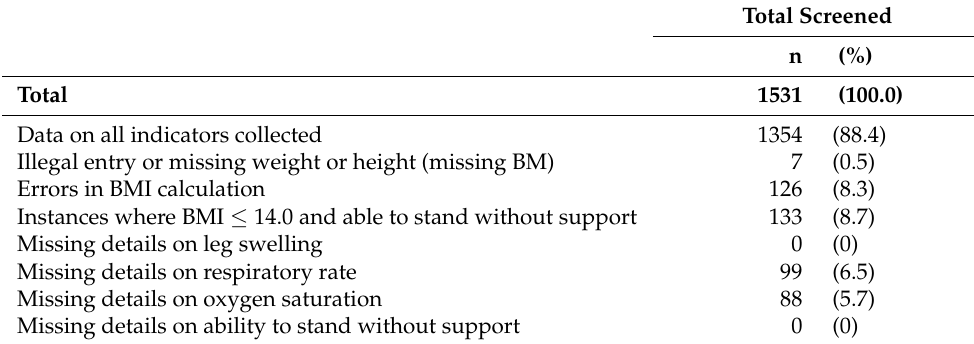
Table 3. Missing data and errors in data collected during screening for ‘high risk of severe illness’